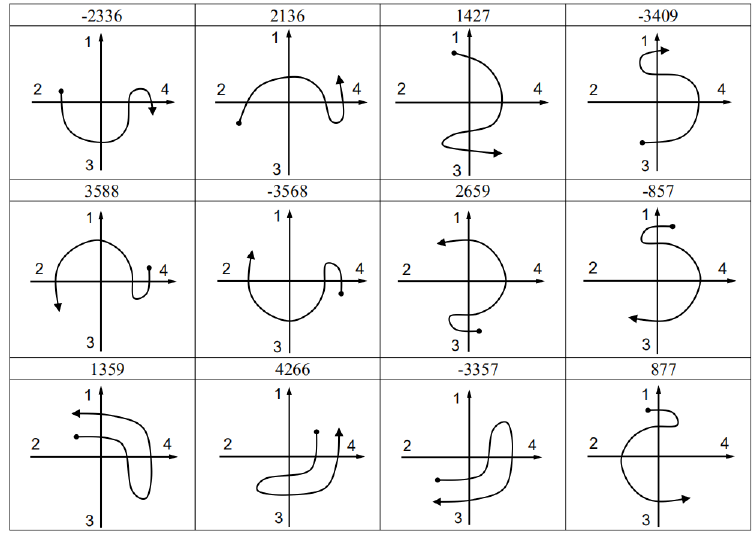
Figure A1. Code templates and sketch maps of up gesture.